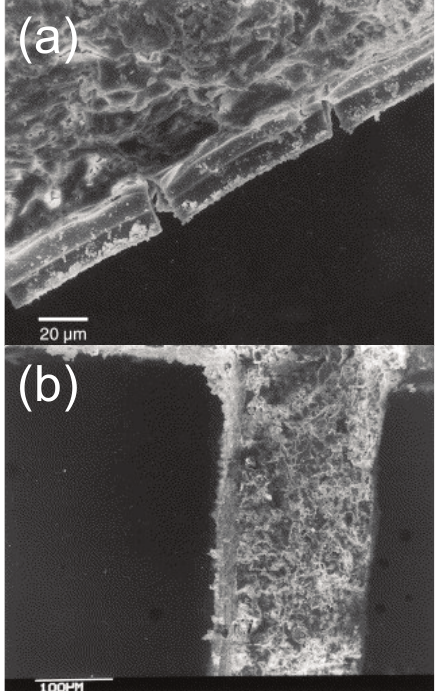
O primer and ( b ) La 2 3